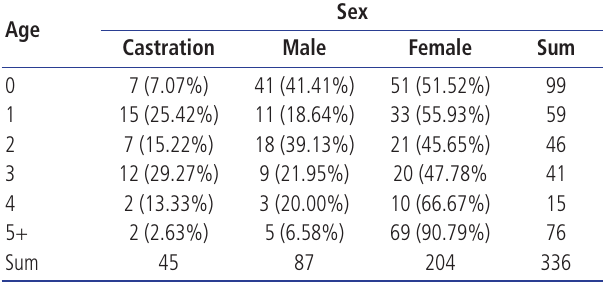
Table 2. Distribution of culling Chikso by sex and age